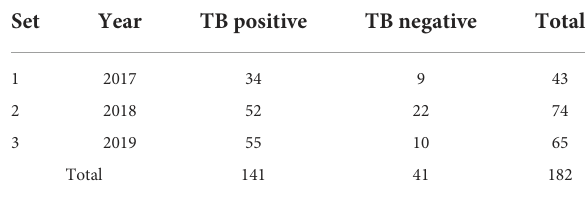
TABLE 2 Sets used for